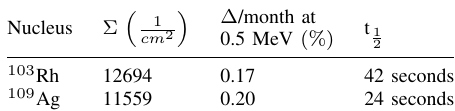
Fig. 4. Visualization of an SPND from within the simulation shown as a wire frame to allow a view inside the detector. The white at the center of the detector is the emitter, the yellow is insulator, and the blue is the collector. The green lines are reactor γ rays impinging the detector.